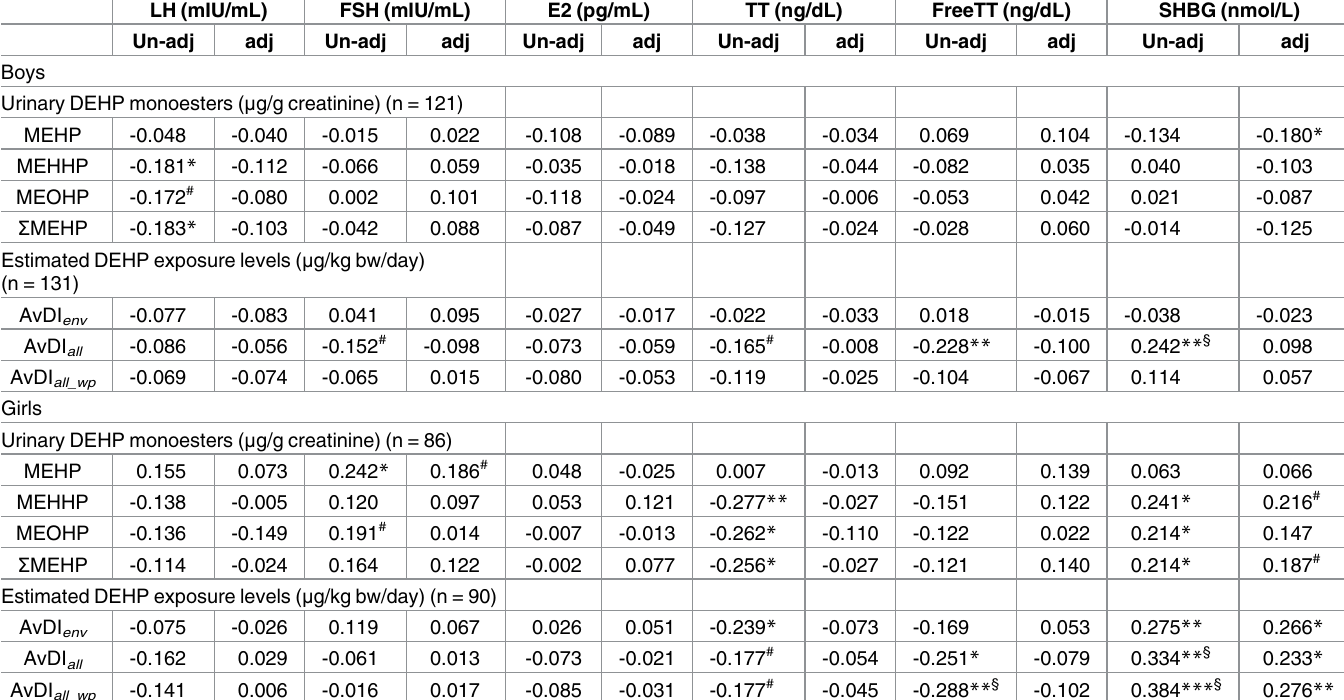
Table 3. Spearman’scorrelation between urinary DEHP monoester and estimated DEHP exposure levels and reproductive hormone concentra- tions in children by sex (n = 222). LH (mIU/mL)